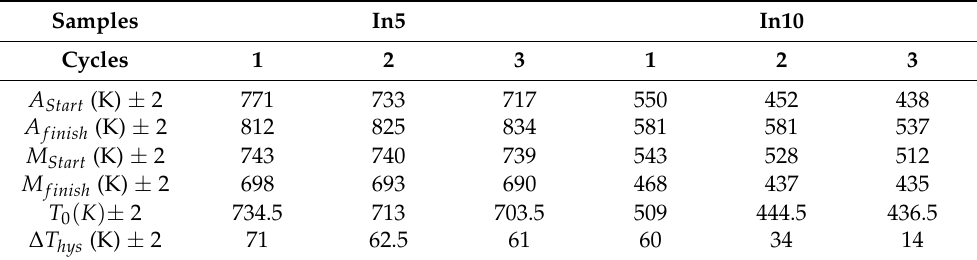
Figure 6. Three successive DSC scans of the AQ-In5 and AQ-In10 ribbons at a heating/cooling rate of 20 K/min. Figure 6 Table 3. The measured characteristic transformation temperatures ( A start , A finish , M start , and M finish ), the calculated equilibrium (T 0 ), and thermal hysteresis ( ∆ T hys )